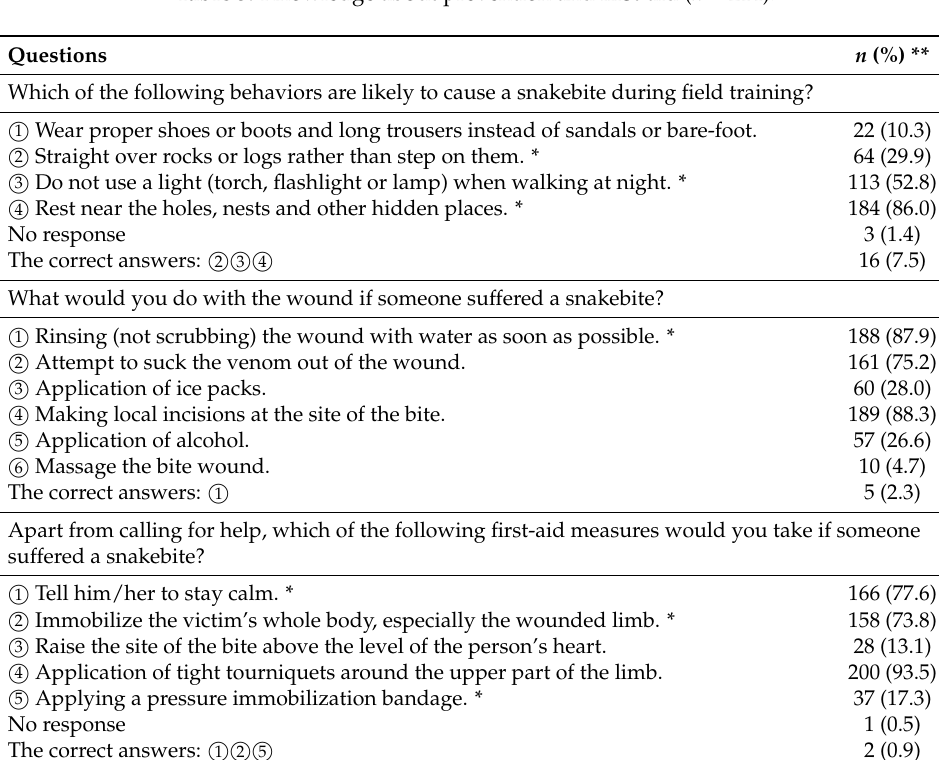
Table 3. Knowledge about prevention and first-aid ( n =